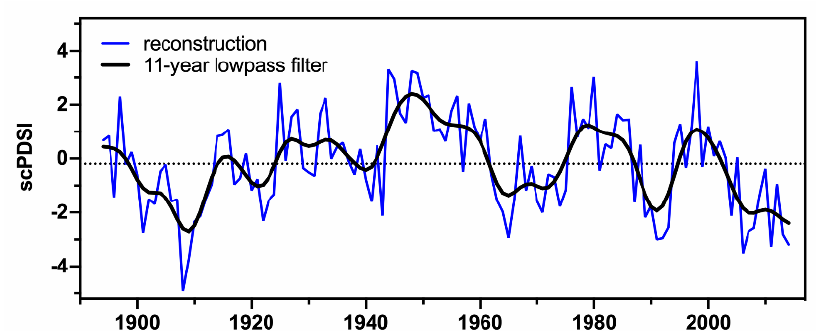
Figure 8. Tree ring-based scPDSI reconstruction (thin line) in the east Pearl River basin during the reliable period 1894–2014. The bold line denotes the series smoothed with 11-year low-pass filter. The horizontal dotted line denotes the mean value of the scPDSI reconstruction. Table 3. The top 10 driest and wettest years of the pMay–cApr scPDSI reconstruction during 1894– 2014 CE.